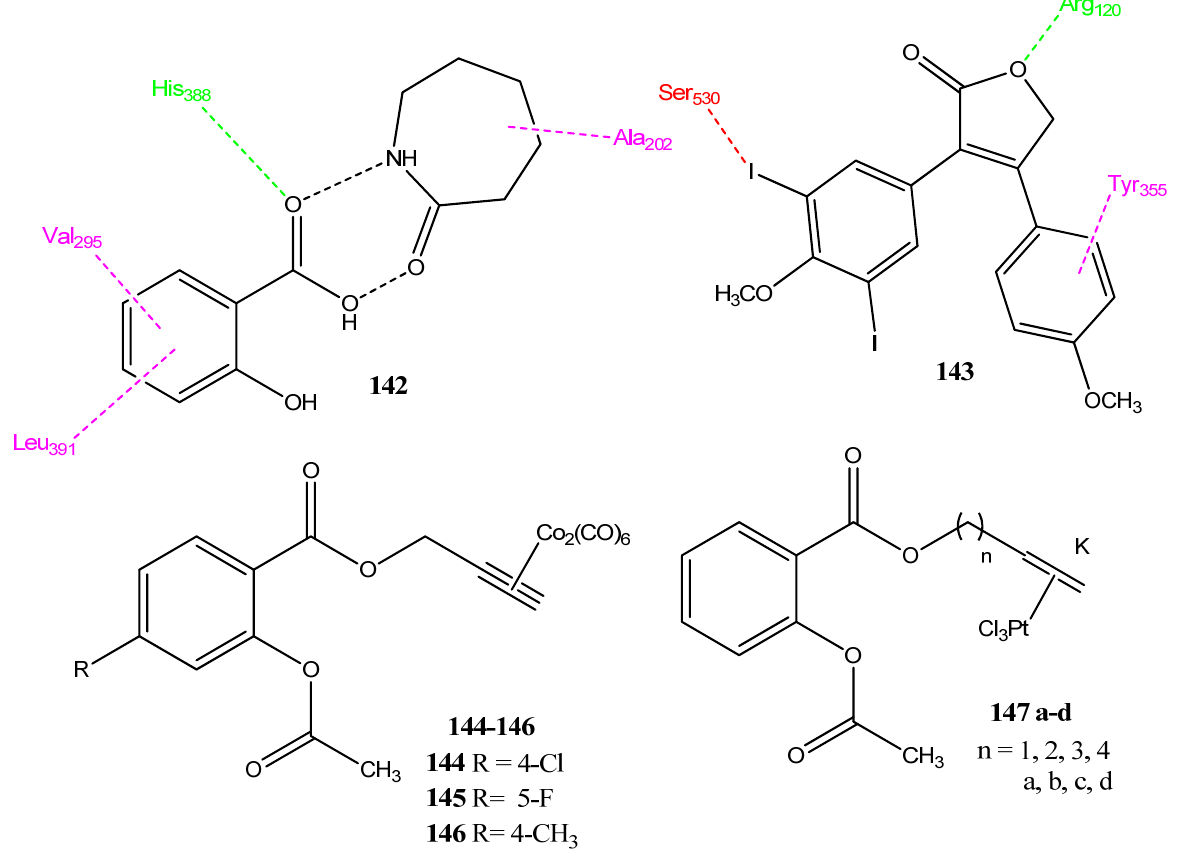
Figure 28. Salicylic acid, rofecoxib, and acetylsalicylic acid–based metal complexes.